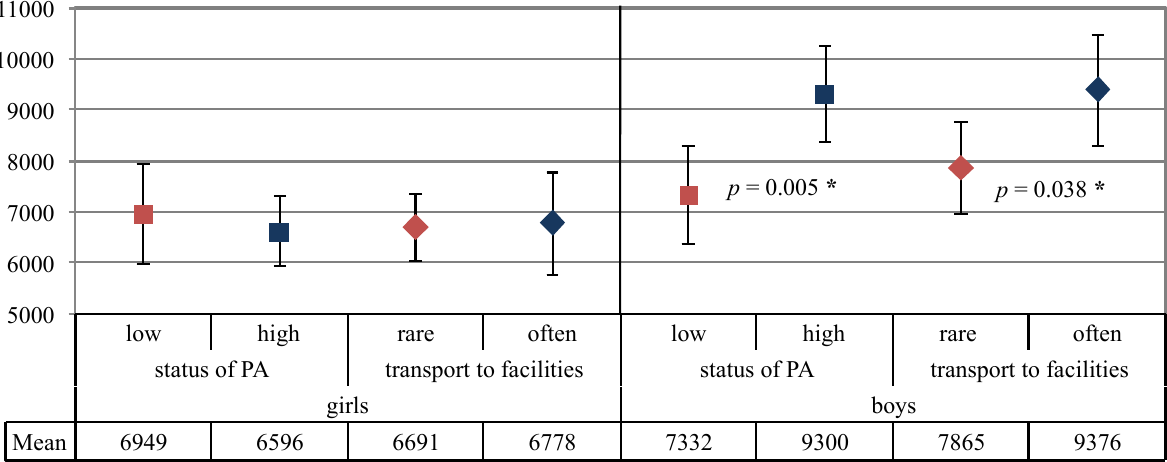
Figure 1. Children’s (n = 113) number of steps per day (mean ± 95% CI) stratified by parental attitudes (towards physical activity), parental support (transport to facilities) and